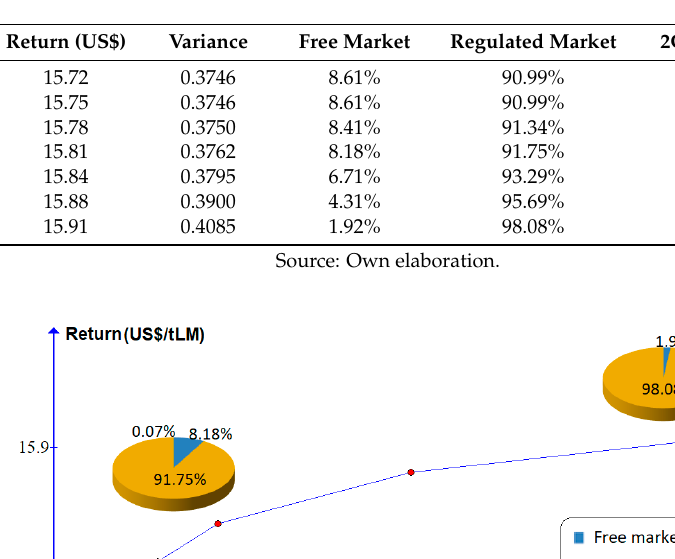
Table 6. Results of the mean-variance model for the base scenario.